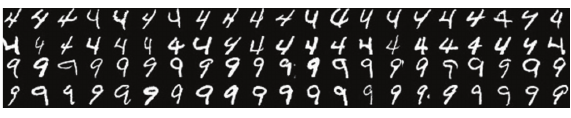
Figure 3: Subset of digits “4” and “9” in the MNIST database.